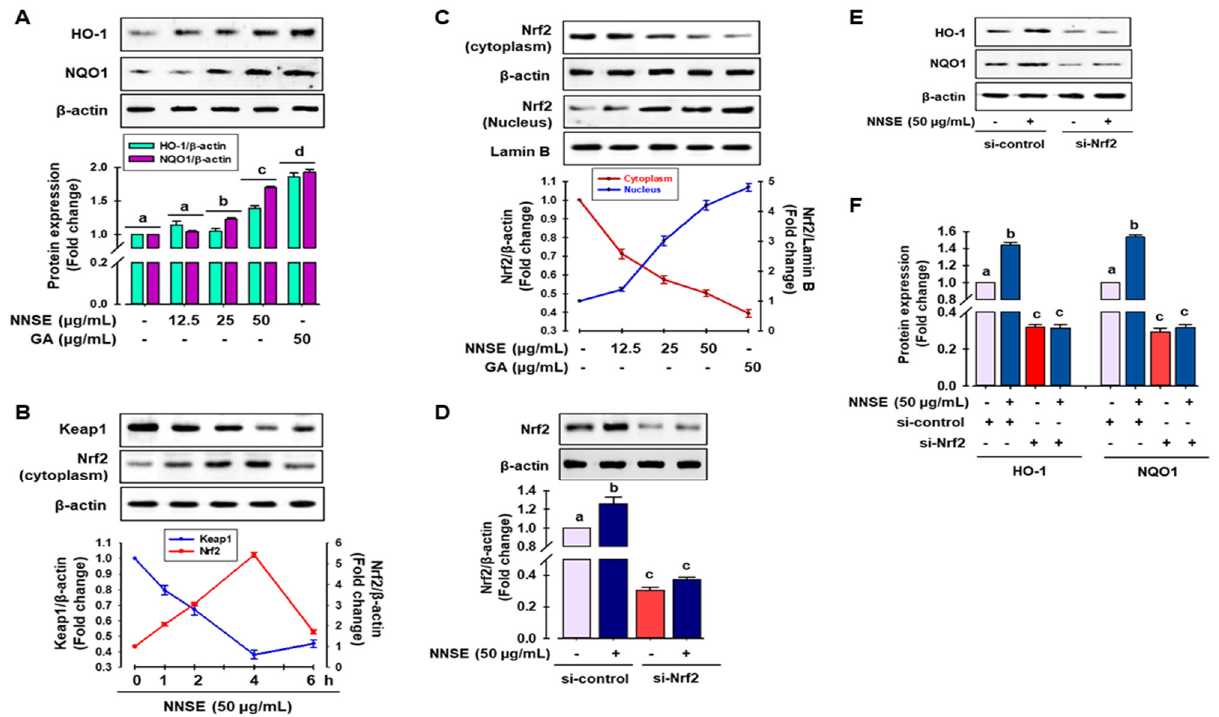
Figure 6. NNSE induces phase II antioxidant enzymes through Nrf2 activation. ( A ) RAW 264.7 cells were treated with NNSE for 24 h, and phase II antioxidant enzyme expression was determined by immunoblotting assay. ( B ) RAW 264.7 cells were treated with NNSE (50 µg/mL) for various times, and the levels of cytoplasmic Keap1 and Nrf2 protein were confirmed by western blot analysis. ( C ) Cells were treated with NNSE and gallic acid for 4 h, and nuclear translocation of Nrf2 was measured by immunoblotting assay. Cells were treated with NNSE in the presence or absence of si-Nrf2 RNA, and the level of ( D ) Nrf2, and ( E ) HO-1, and NQO1 protein was measured by western blot analysis. ( F ) The relative expression of HO-1 and NQO1 protein was quantified by Image J software. Values are expressed as the mean ± SD ( n = 3), and different letters are considered statistically significant ( p < 0.05) to one another. GA, gallic acid.